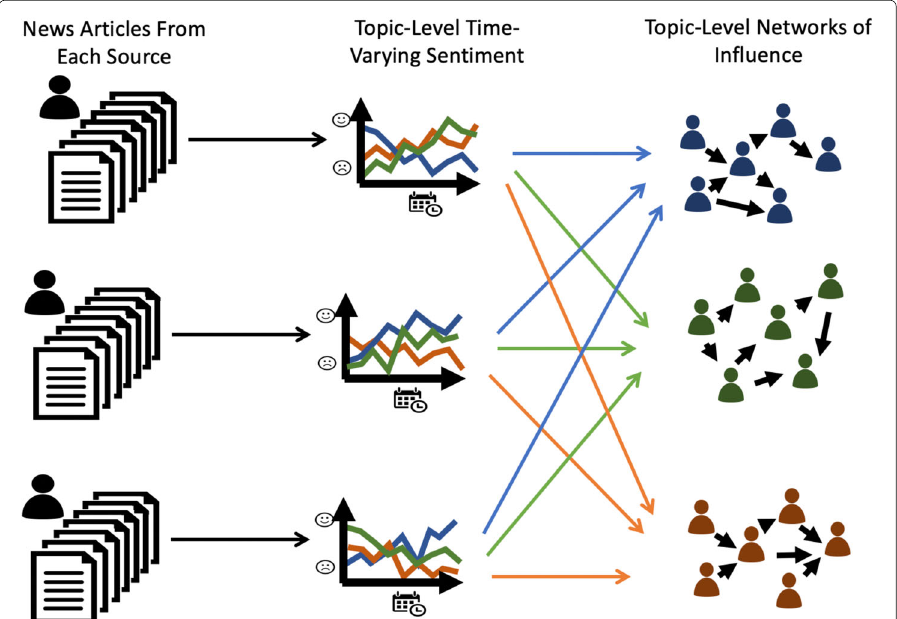
Fig. 1 The network-construction process: A topic-specific sentiment time-series is inferred for each news source based on the content that they publish. Networks are inferred for each topic based on the empirically measured conditional dependence between the sentiment time-series of the news